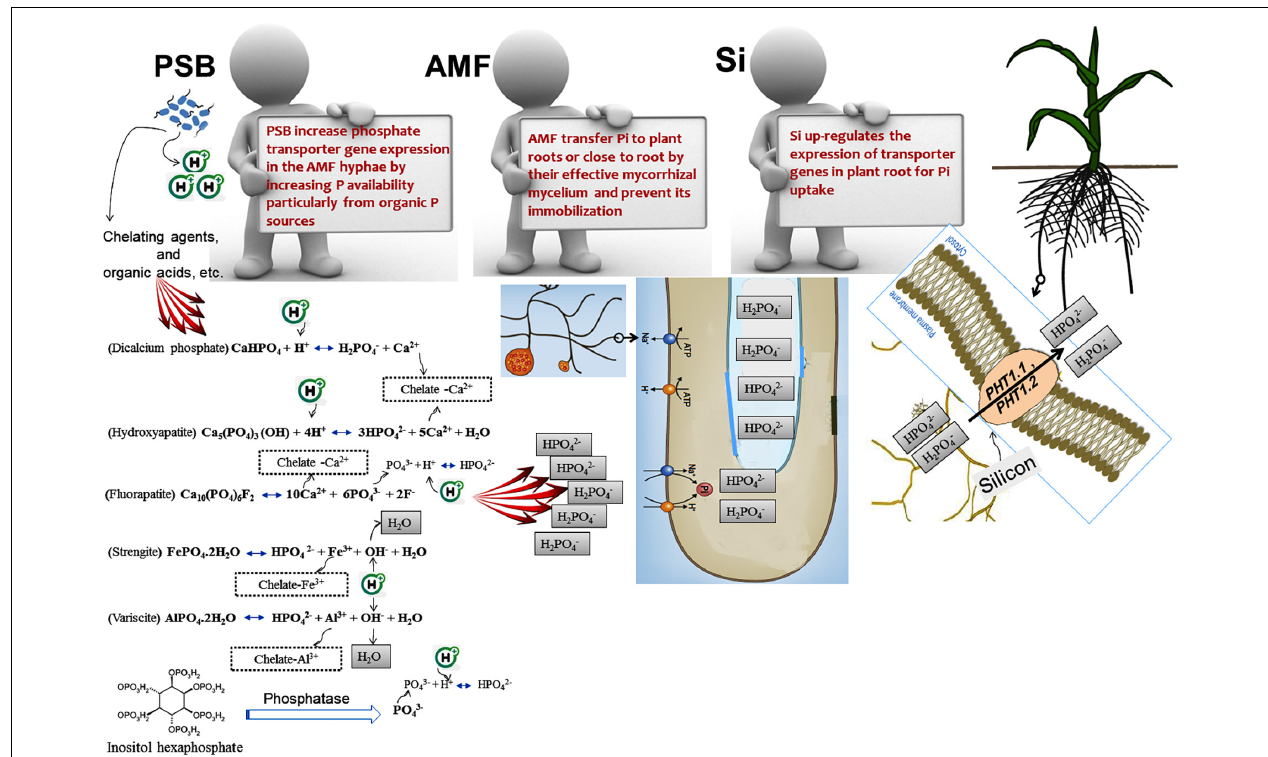
FIGURE 5 | Synergetic role of among arbuscular mycorrhizal fungi (AMF), phosphate-solubilizing bacterium (PSB), and silicon (Si) in improving phosphorus (P) uptake by